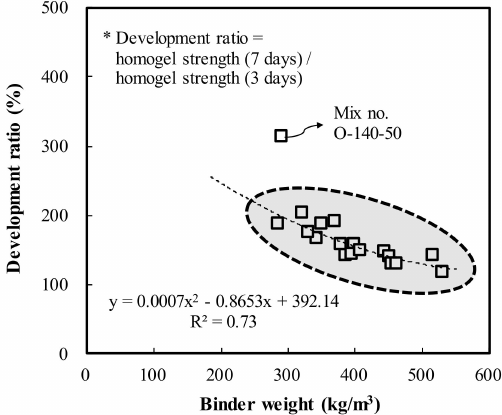
Figure 6. Homogel strength of OPC and AAC by binder weight: ( a ) 3 days ( b ) 7 days.